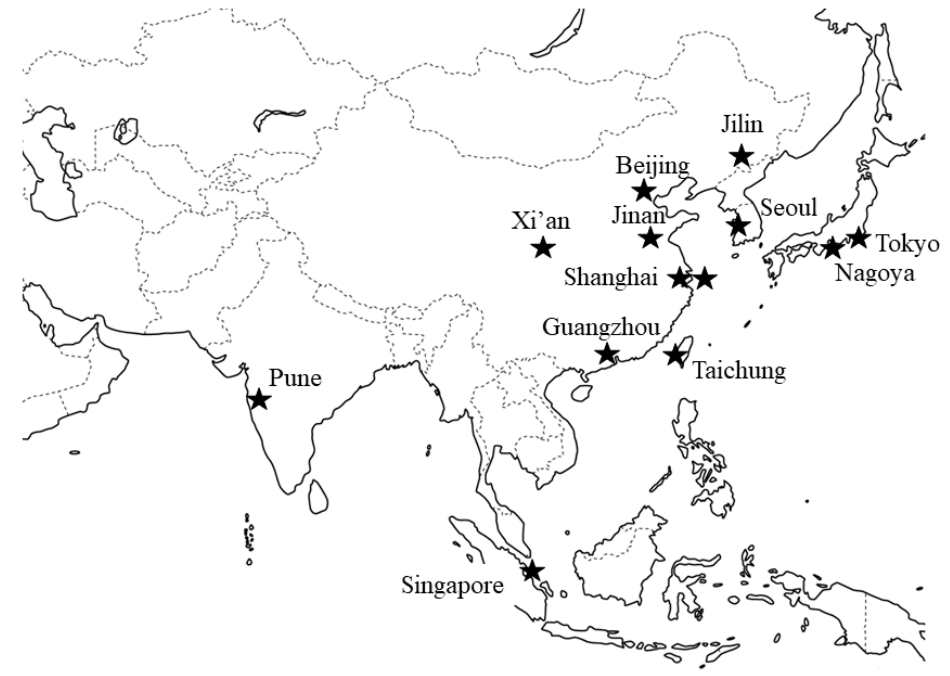
Figure 1. Current groups for UTx (uterus transplantation) research in Asia. Table 1. Groups performing UTx (uterus transplantation) research in Asia.